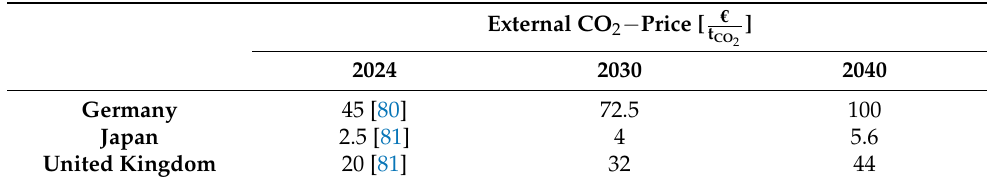
Table 5. Assumed external CO 2 -prices.